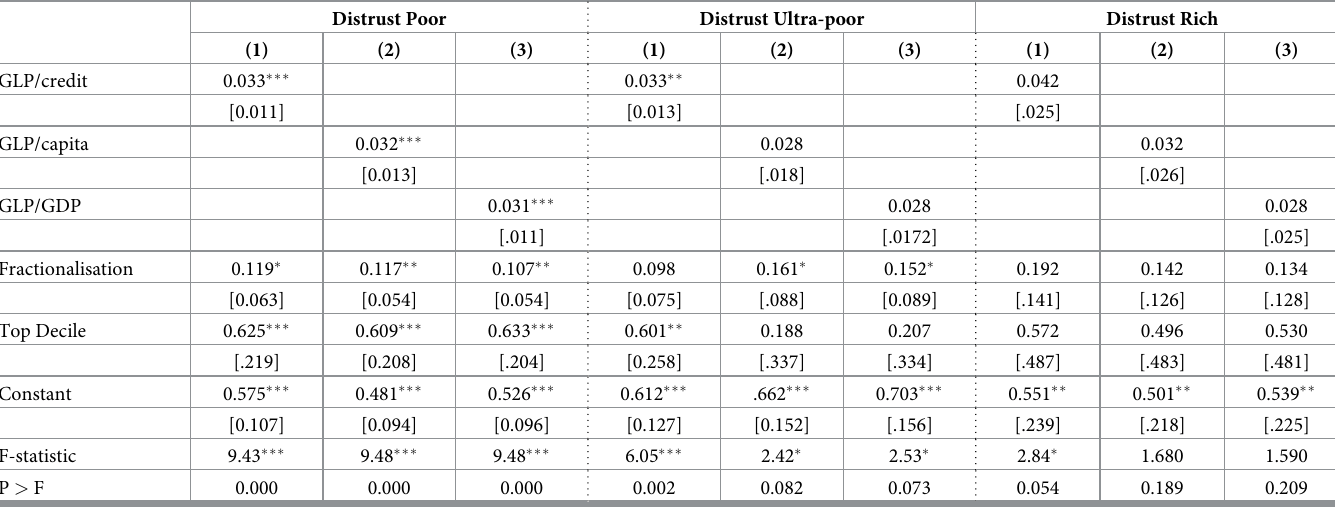
Table 2. Results of 2019 OLS (dependent variable: Distrust—by income